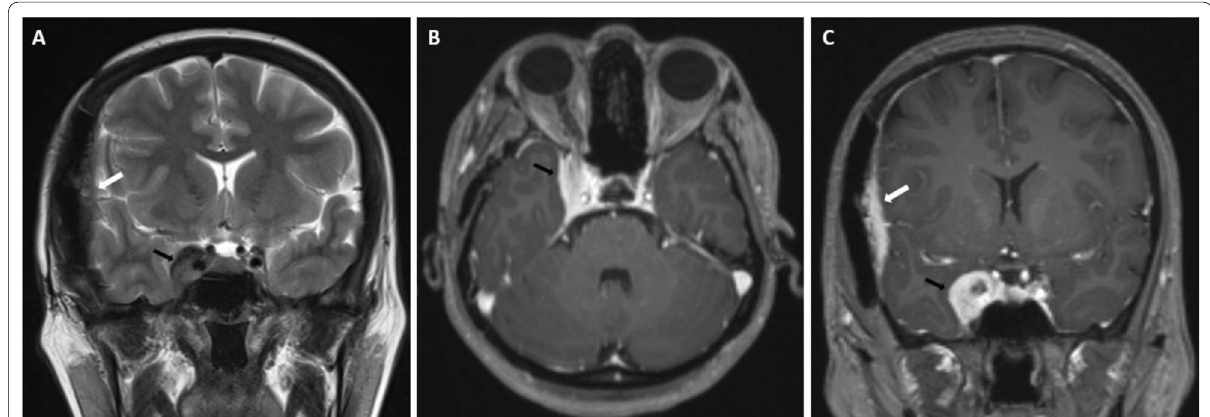
Fig. 3 Postoperative T2-weighted coronal ( A ), postcontrast axial ( B ) and coronal ( C ) images show a residual-relapse area of the lesion in the right frontotemporal region (white arrow). The expansion and enhancement of the right cavernous sinus appears to progress (black